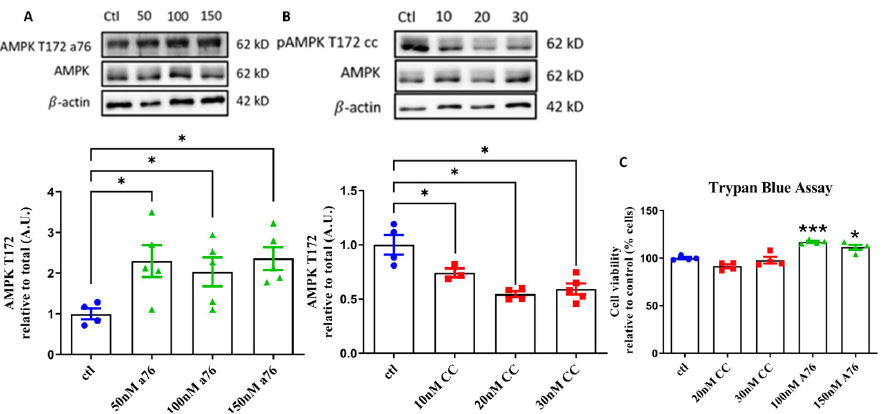
Figure 1. Dose response of Compound C (CC) and A-769662 (A76) on AMPK phosphorylation and cell viability. Western blot analysis for phosphorylated AMPK T172 in SH-SY5Y neuroblastoma cells following 24 h treatments of AMPK activator A-769662 (( A ) 50 nM, 100 nM, 150 nM; green triangles) and inhibitor Compound C (( B ) 10 nM, 20 nM, 30 nM; red squares). Control is shown as Blue circles. Representative Western blots provided above figures. Cell viability as assessed by Trypan blue exclusion assay following 7 days of treatments (( C ) 20 nM, 30 nM, 100 nM, 150 nM). Results represent 3–5 independent experiments. Data are presented as mean ± SEM. * Indicates significant ( p < 0.05) difference from ctl, *** Indicates significant ( p < 0.0005) difference from ctl as determined using a one-way ANOVA followed by Tukey’s post hoc